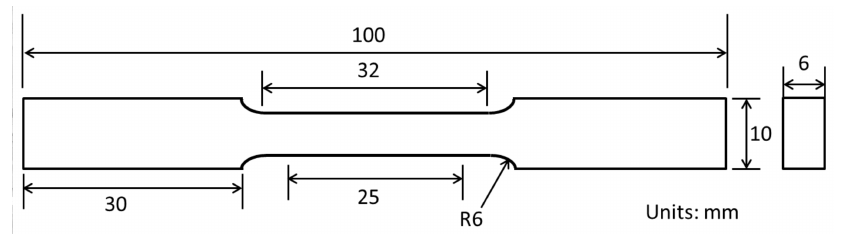
Figure 2. Dimension of tensile